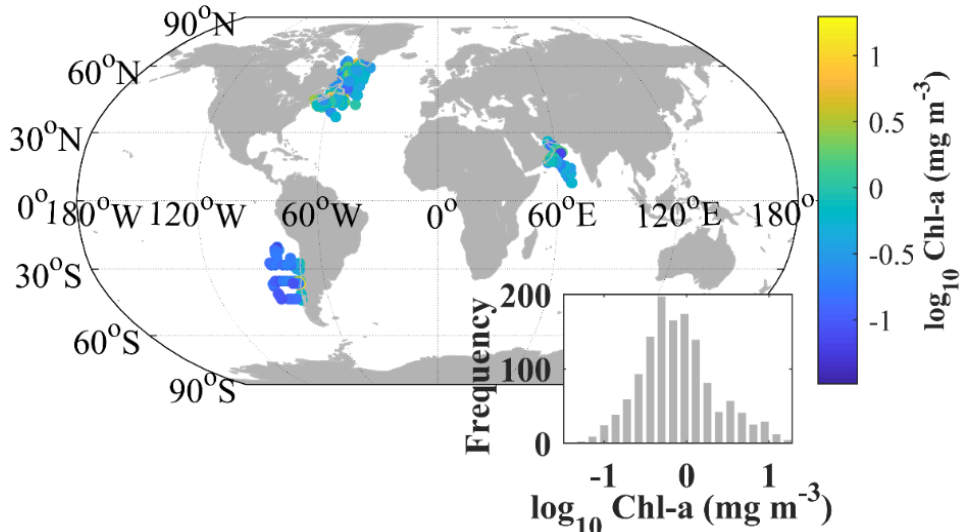
Figure 1. Locations of sites where phytoplankton absorption spectra were measured together with concentrations of major pigments. Inset shows the distribution of all log-transformed chlorophyll-a (Chl-a) data.